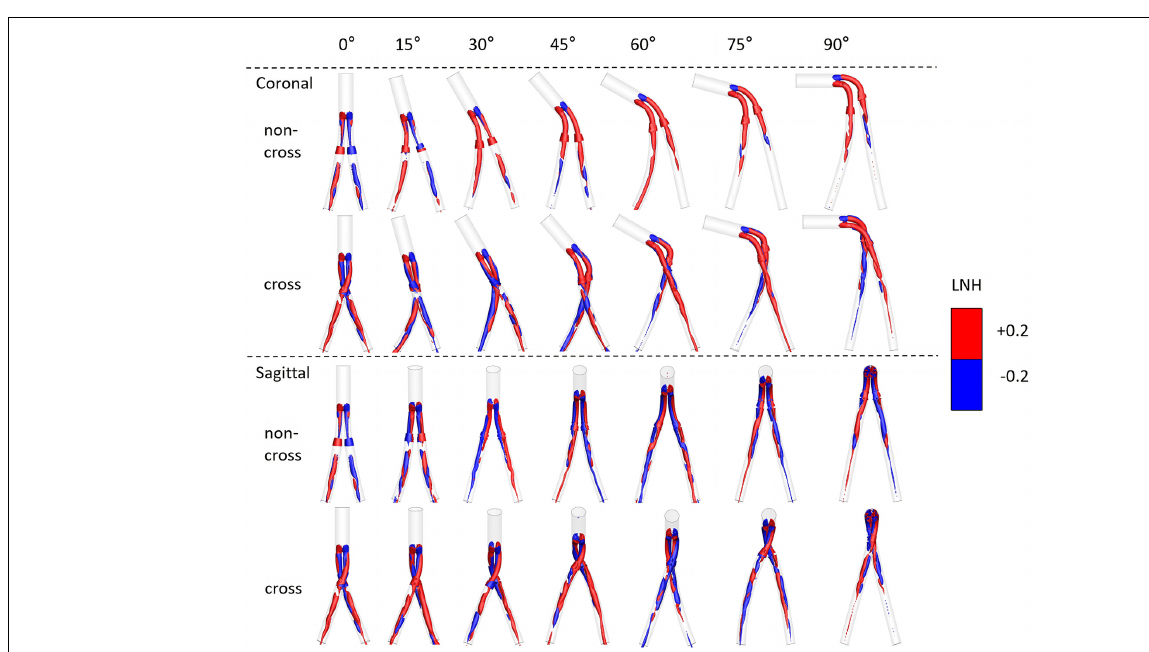
neck angle have little effect on the pressure